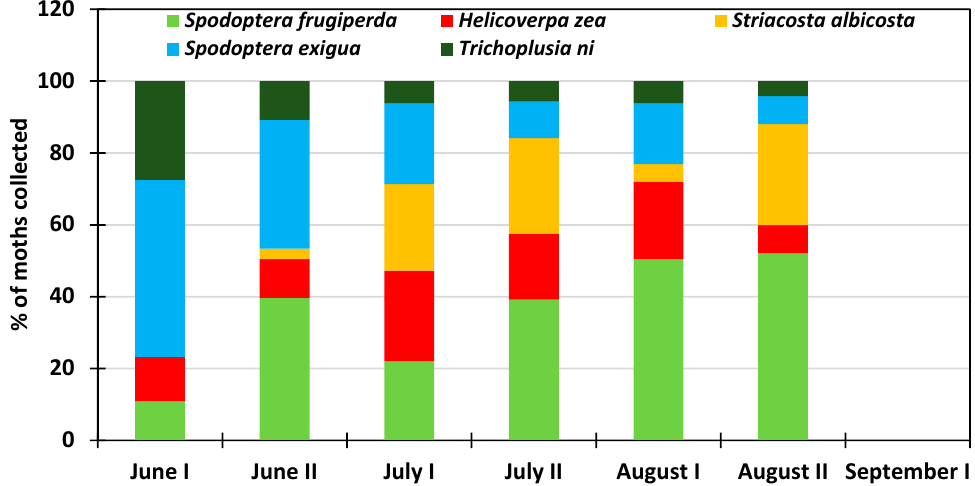
Figure 8. Average proportion of moths collected during the 2016–2017 period at NAPI commercial field.